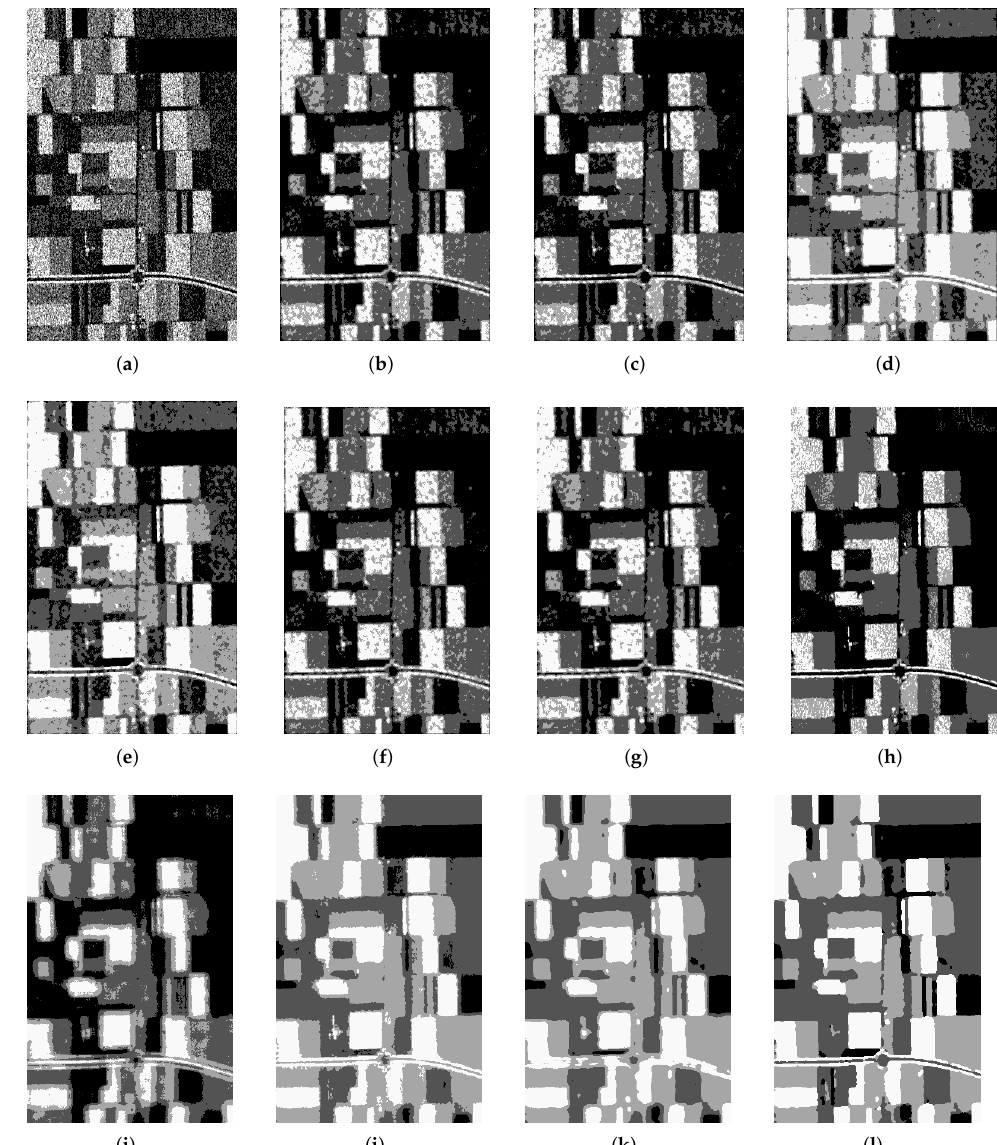
Figure 12. The segmentation result of each algorithm on the real SAR image. ( a ) FCM. ( b ) FCM_S1. ( c ) FCM_S2. ( d ) KFCM_S1. ( e ) KFCM_S2. ( f ) EnFCM. ( g ) FGFCM. ( h ) FCM_NLS. ( i ) NS_FCM. ( j ) RFCM_BNL. ( k ) LBNL_FCM. ( l )